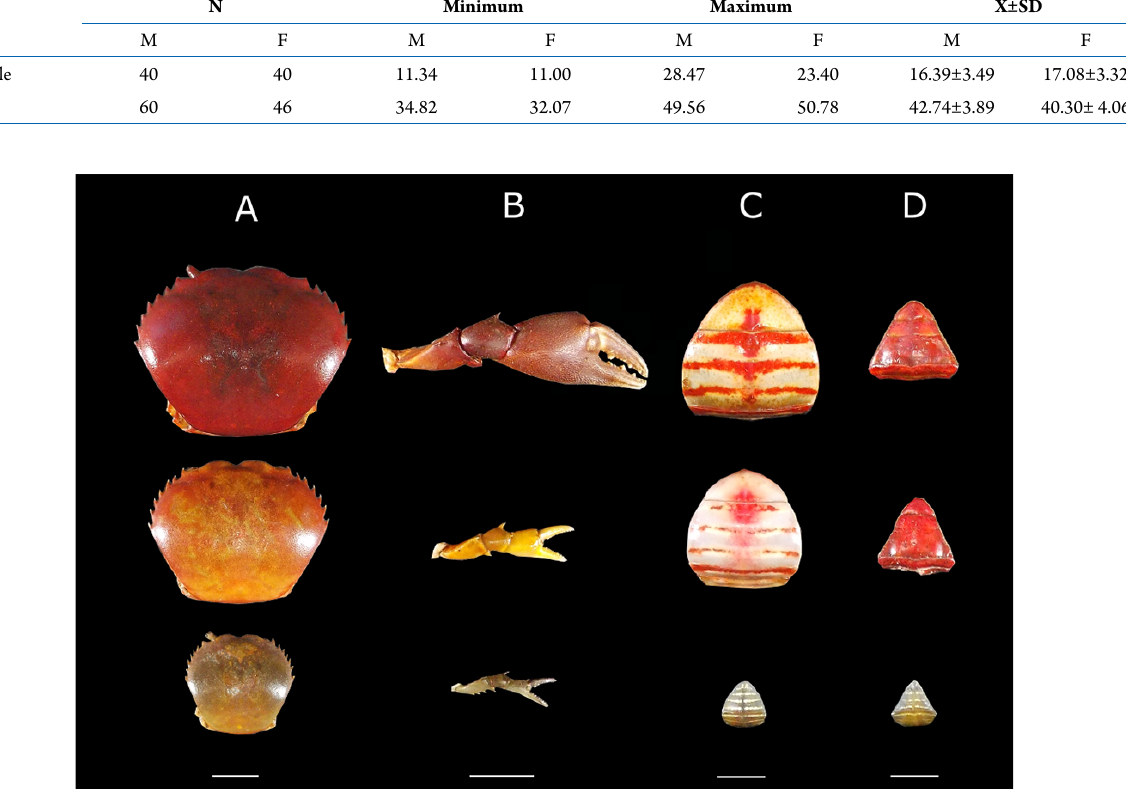
Figure 2. Color variation of Dilocarcinus pagei separated by size and morphological structure. ( A = cephalothorax; B = chelipeds; C = female abdomen; D = male abdomen; scale bar = 1